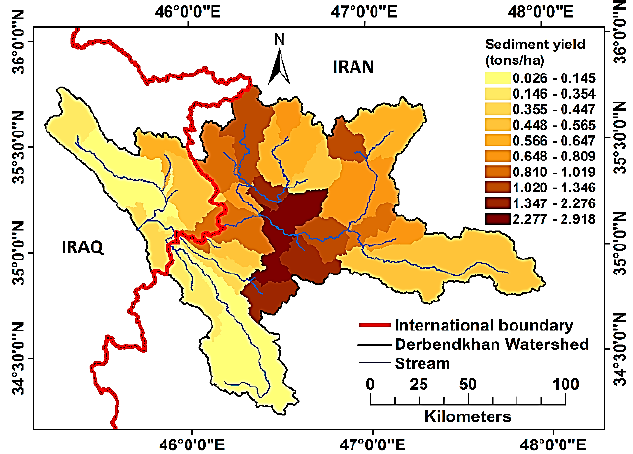
Figure 17. Average sediment yield for the Derbendkhan Watershed at the sub-basin level for the period from 1984 to 2013.